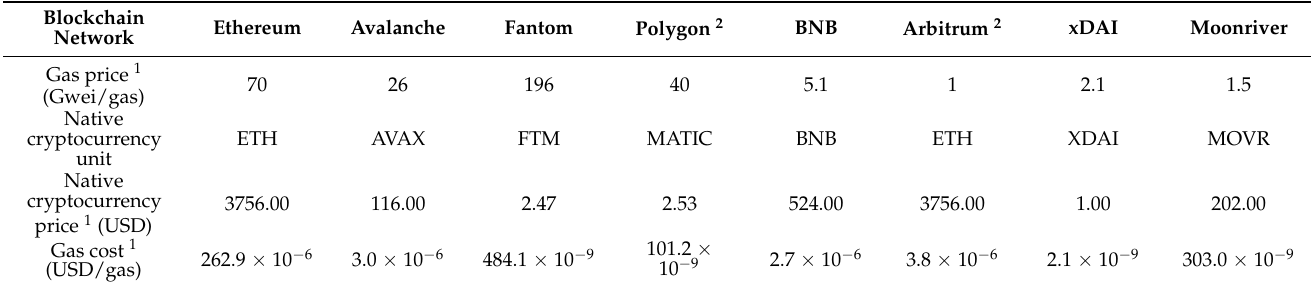
Table 3. Gas costs for the key EVM-compatible blockchain networks